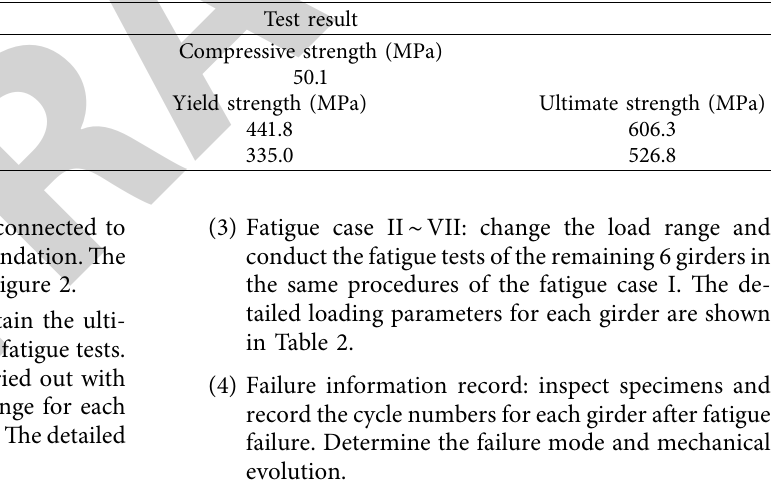
Figure 1: Geometry of the test girders (unit: mm). Table 1: Girder material test